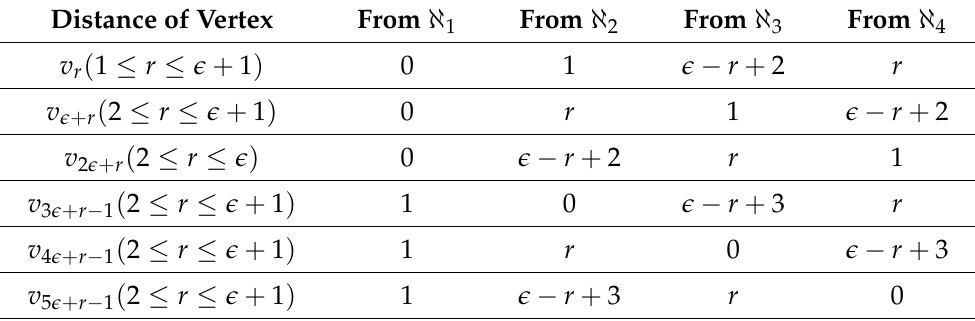
Table 8. Distance codes of V ( f α × 3 ) with respect to ℵ .